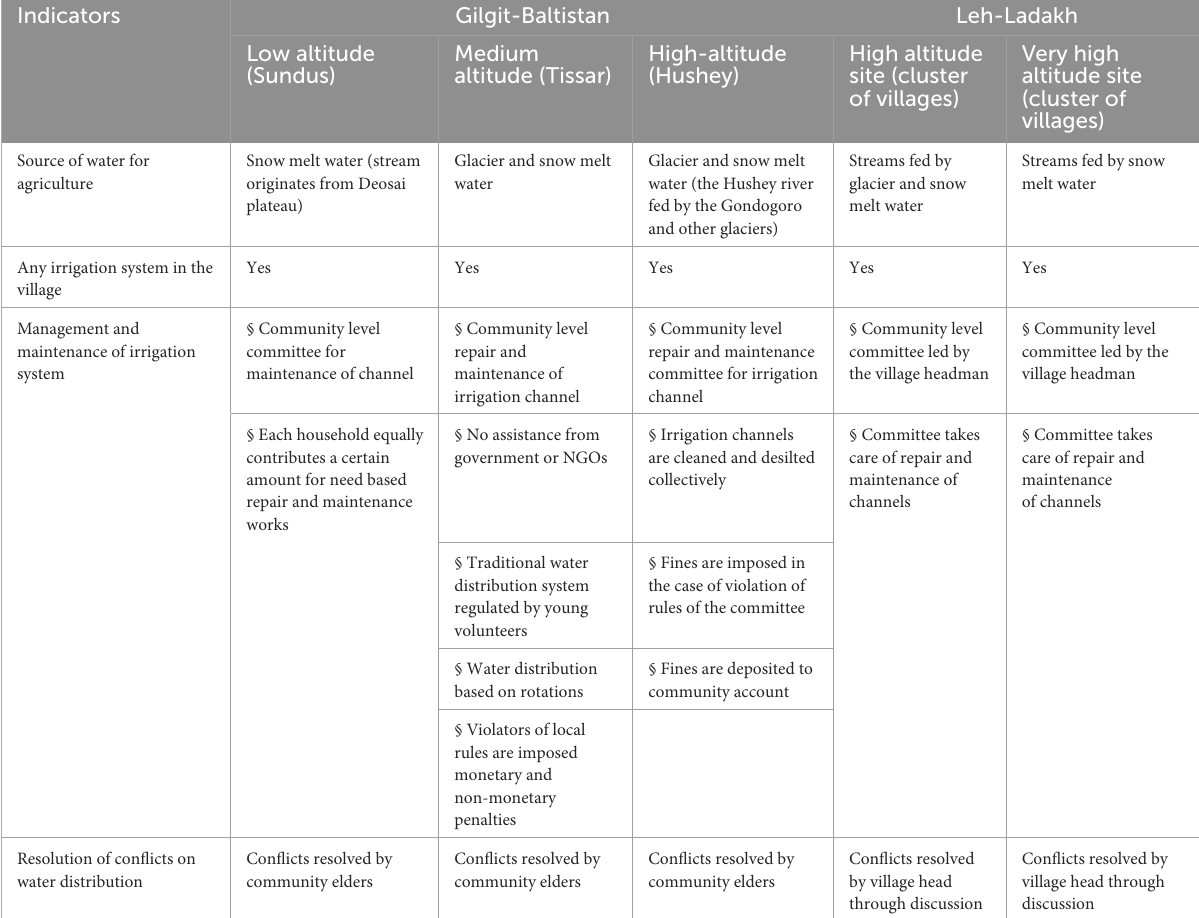
TABLE 3 Water resources for